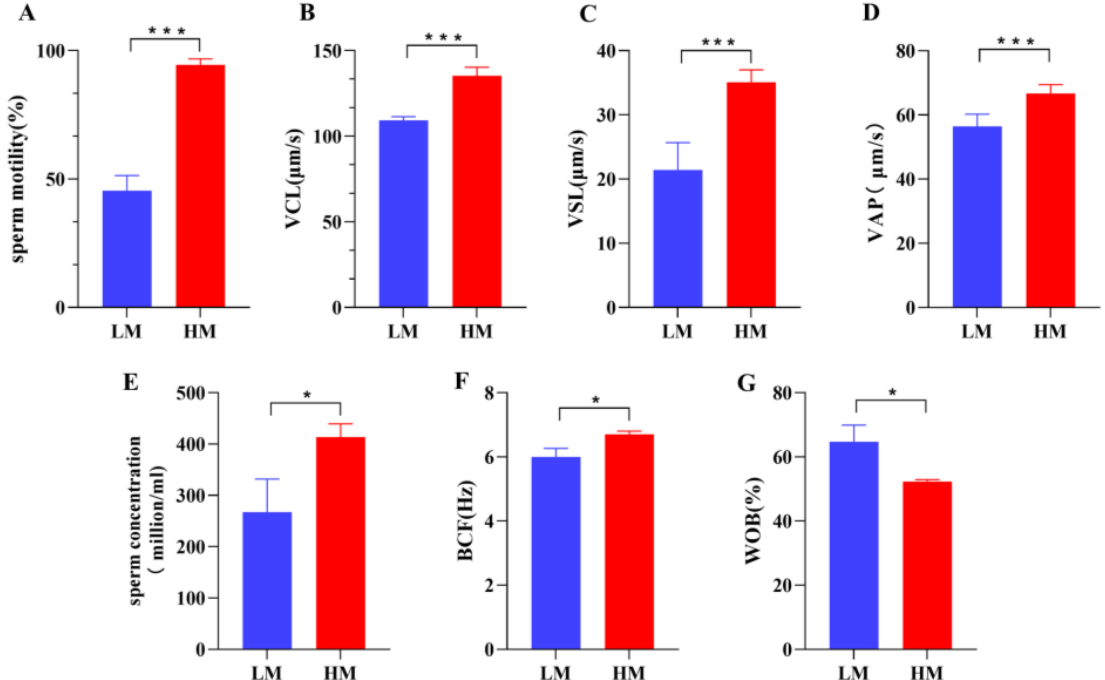
Figure 1. There were significant differences in various kinematic parameters of sperm between the LM and HM groups: ( A ) sperm motility (%), ( B ) VCL (curvilinear velocity, µ m/s), ( C ) VSL (linear velocity, µ m/s), ( D ) VAP (average path velocity, µ m/s), ( E ) sperm concentration (million/mL), ( F ) BCF (beat/cross frequency, Hz), ( G ) WOB (wobble, %). * p < 0.05, *** p < 0.001. LM, low-motility group; HM, high-motility group.